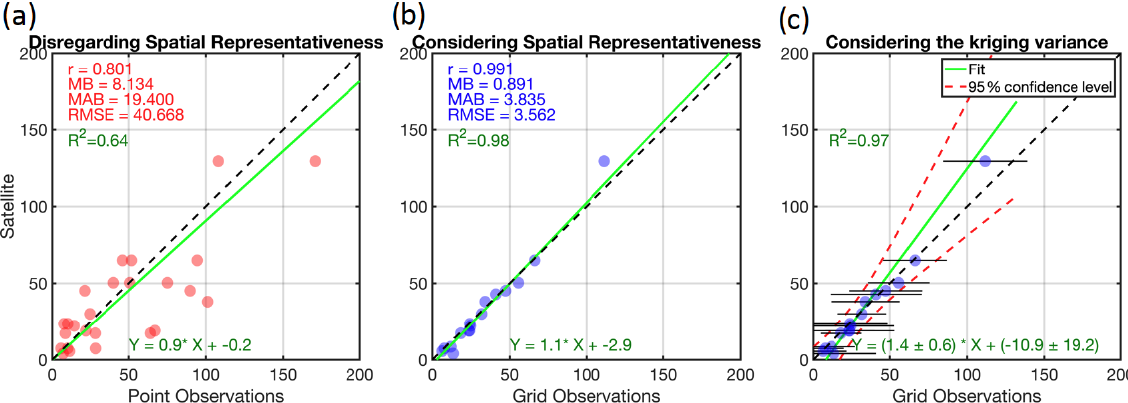
Figure 8. (a) The direct comparison of pseudo observations of a satellite observing the C5 case at 30 × 30 resolution vs. the 25 samples used for C5opt. (b) Same for the y axis, but the point samples are transformed to grid boxes using kriging convolved with the satellite spatial response function (ideal box with 30 × 30 kernel size). The differences in statistics between these two experiments speak to the problem of scale. Panel (b) ignores the kriging errors but panel (c) incorporates them using a Monte Carlo method. Note that the best linear fit has changed, indicating that the consideration of the kriging variance is critical. MB: mean bias (point minus satellite); MAB: mean absolute bias; RMSE: root mean square error; R 2 : coefficient of determination.